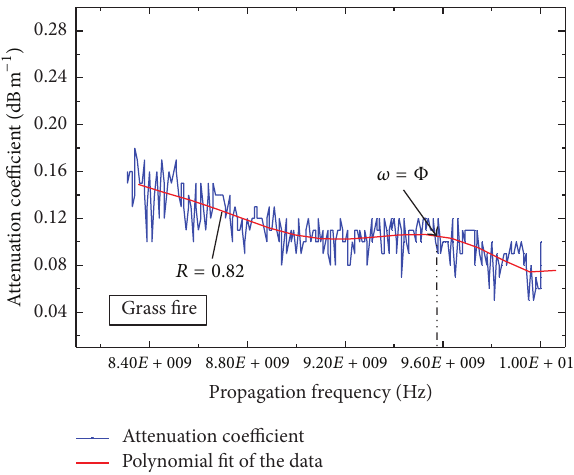
Figure 5: Grass fire absorption maxima and collision frequency.